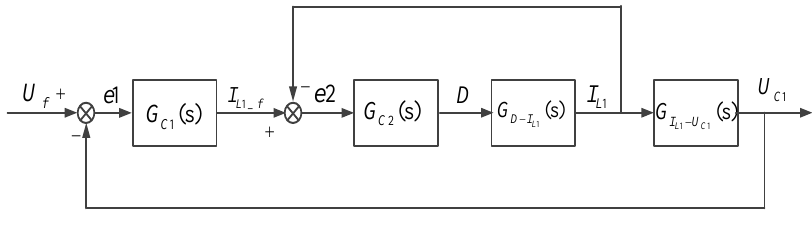
Figure 8. Double closed-loop control system.